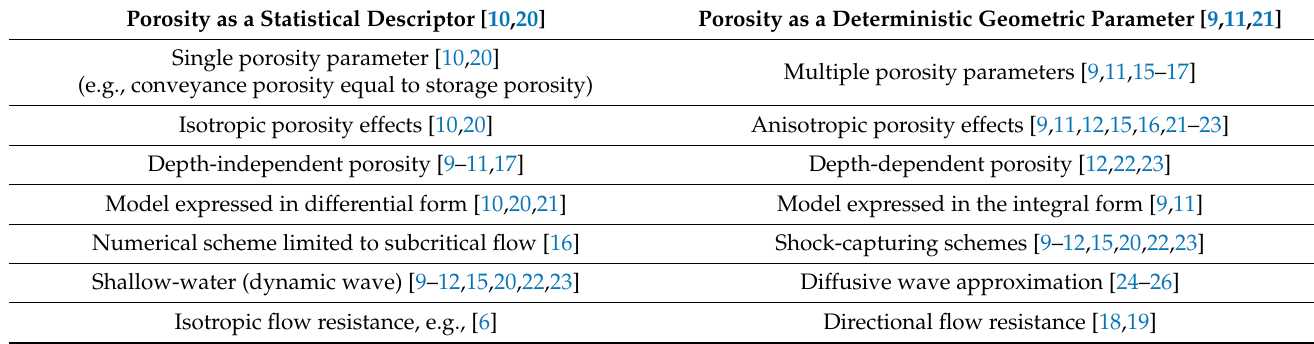
Table 1. Dualities in existing porosity